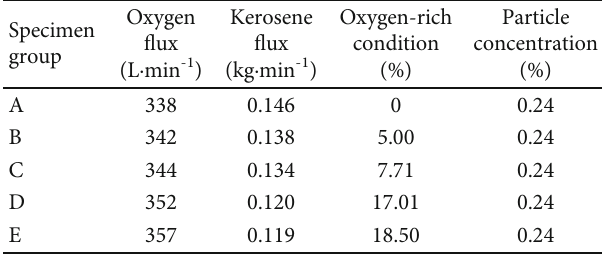
Table 3: Program of the ablation test.